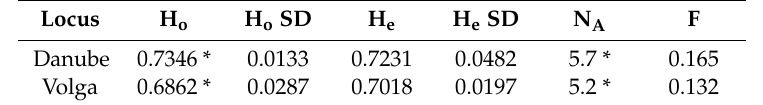
Table 3. Summary statistics of the genetic variation in the Danube and Volga populations of sterlet. Locus H o H o SD H e H e SD N